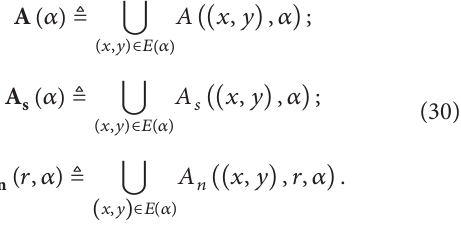
(eASA) for each single edge of a tour. Let 𝐸(𝛼) be all the edges of a tour 𝛼 ; for all 𝛼 ∈ 𝑀(𝑆) , for all (𝑥, 𝑦) ∈ 𝐸(𝛼) 𝐴 ((𝑥, 𝑦) ,